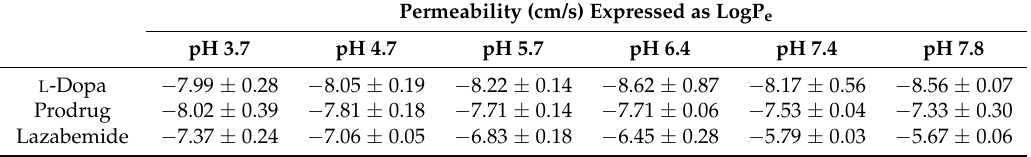
Table 4. The permeability (P e ) of the L -dopa–lazabemide prodrug, lazabemide and L -dopa at selected pH